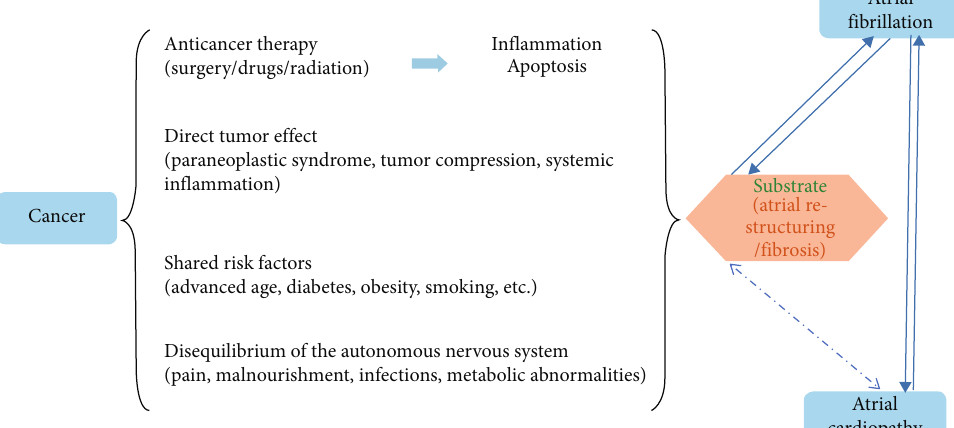
Figure 1: Schematic overview of the link between cancer, atrial fibrillation, and atrial cardiomyopathy. Shared factors may predispose to a comorbidity state of cancer, atrial cardiomyopathy, and atrial fibrillation. Cancer may cause atrial fibrillation and atrial cardiomyopathy by anticancer therapy, autonomous nervous system (ANS) imbalance, direct tumor effect, and other abnormalities. These factors may have direct effects on the left atria (LA) substrate and lead to systemic inflammation and apoptosis. Then, they promote or result in fibrosis and structural remodeling, leading new-onset or existing atrial cardiopathy progress to atrial